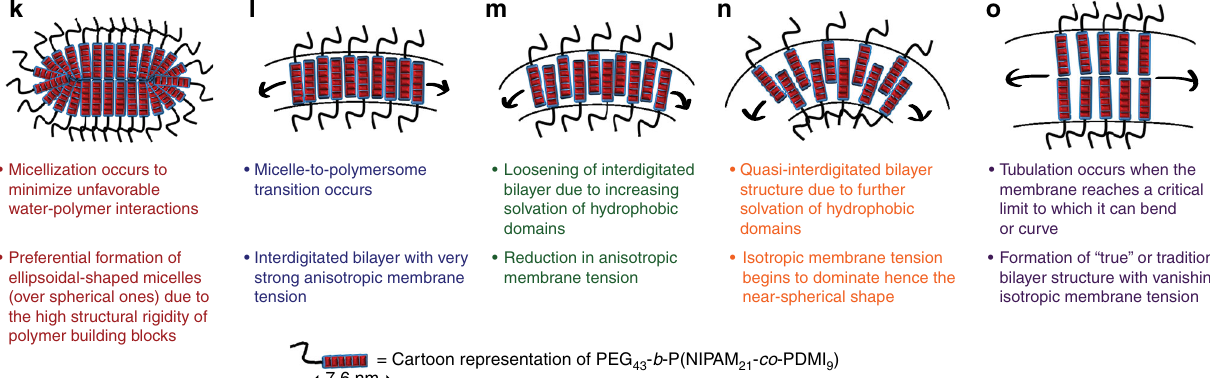
Fig. 2 TEM images and proposed self-assembly pathways for the different morphologies observed. a – e TEM images. The insets in a – c are higher magni fi cation TEM images. f – j cryo-TEM images. The insets in g – j are higher magni fi cation cryo-TEM images and intensity plot pro fi les used to estimate membrane thickness of individual polymersome morphology. For clarity, an enlarged region of the same cryo-TEM image in j is shown in Supplementary Fig. 6. k – o Schematic representations of the micelle/polymersome structures formed. The black arrows in l – o indicate the direction of membrane tension. Scale bars in a – j are 100, 200, 500, 2000, 2000, 50, 100, 100, 300, and 1000 nm, respectively. Scale bars inset in a – c are 50, 100, and 100 nm,